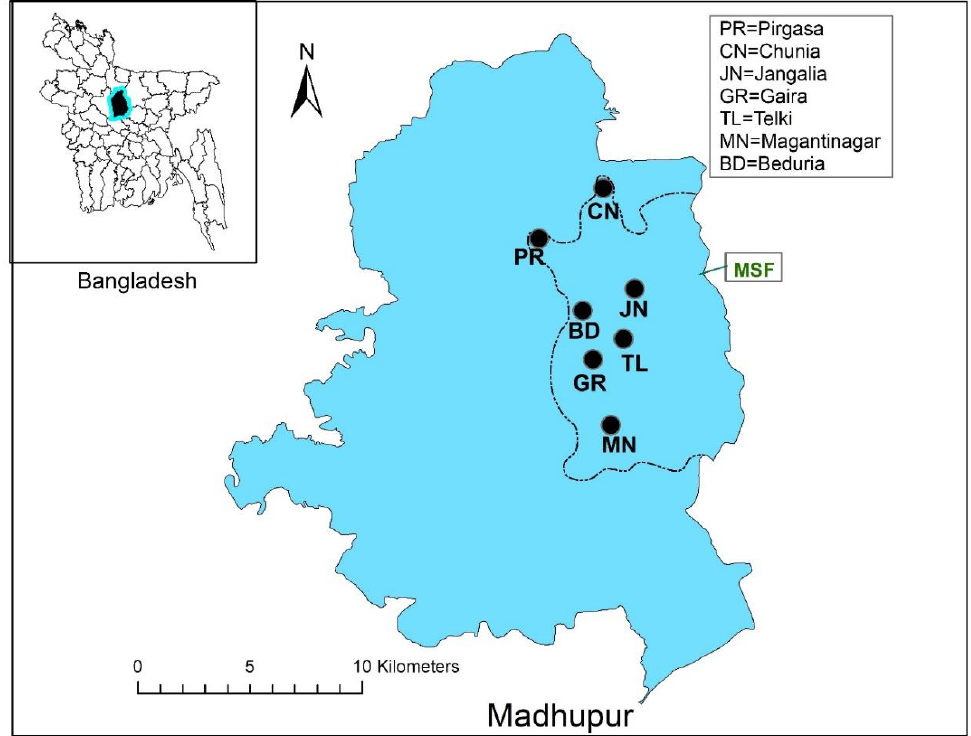
Figure 1. Study villages located in the Madhupur Sal Forest (MSF) area of Bangladesh.